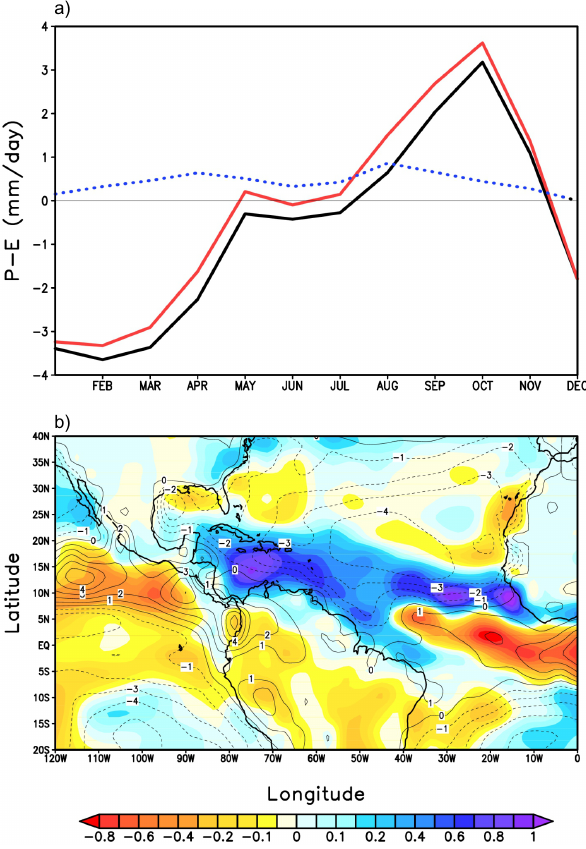
Fig. 11. Precipitation minus Evaporation ( P − E ) anomaly (mmday − 1 ) at 6kaBP inferred from numerical simulations with the coupled general circulation model COSMOS. (a) Normalised annual cycle of P − E (mmday − 1 ) for Pre-Industrial (PI) times (black), 6ka (red) and their difference (blue dotted) averaged over the area of 65–83 ◦ W, 10–20 ◦ N. (b) Annual mean P − E for PI (contour) and for 6ka anomalies relative to PI